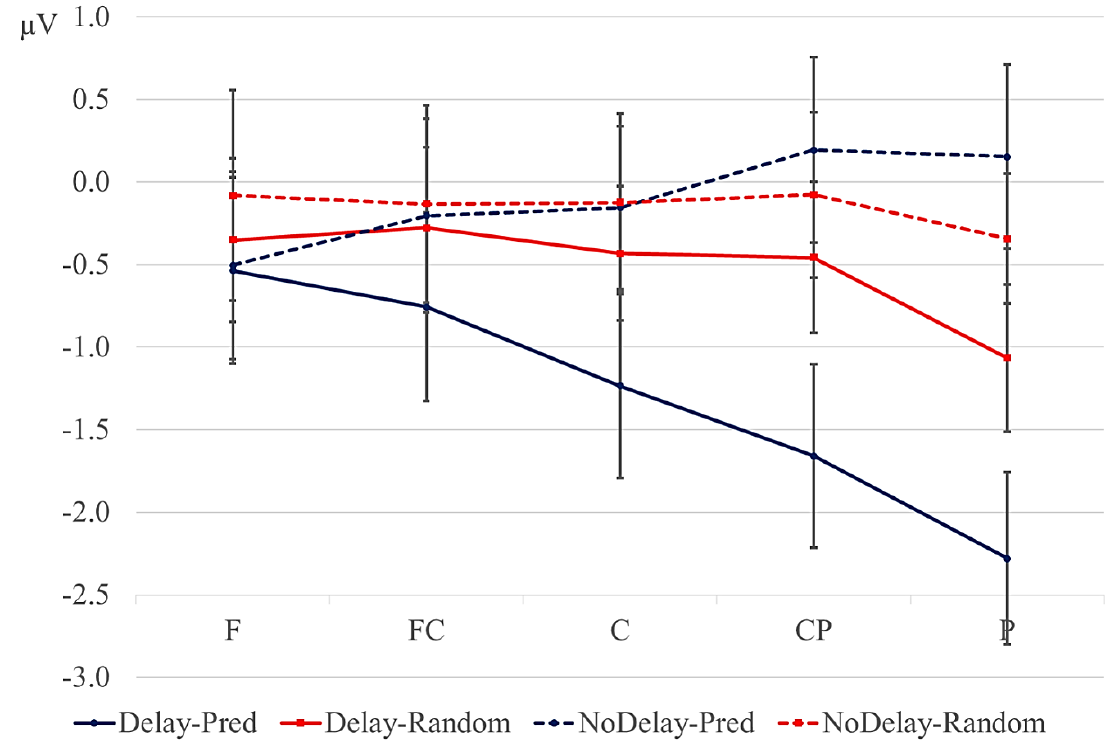
Figure 3. Mean amplitude (µV) in the 600–900-ms window for the lateral regions, collapsed over hemisphere (error bars are standard errors). Blue lines: predictive sequences (Pred); red lines: random sequences; solid lines: delay conditions; dotted lines: conditions without a delay. F: frontal; FC: fronto-central; C: central; CP: central-parietal; P: